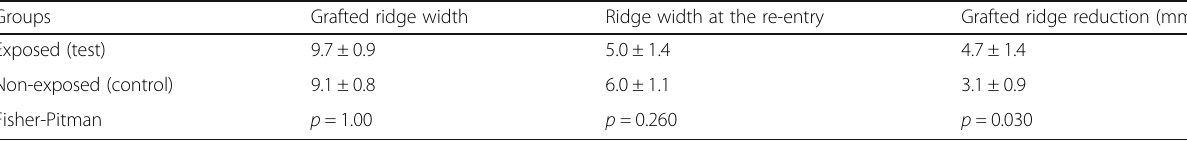
Table 3 Alveolar ridge width reduction